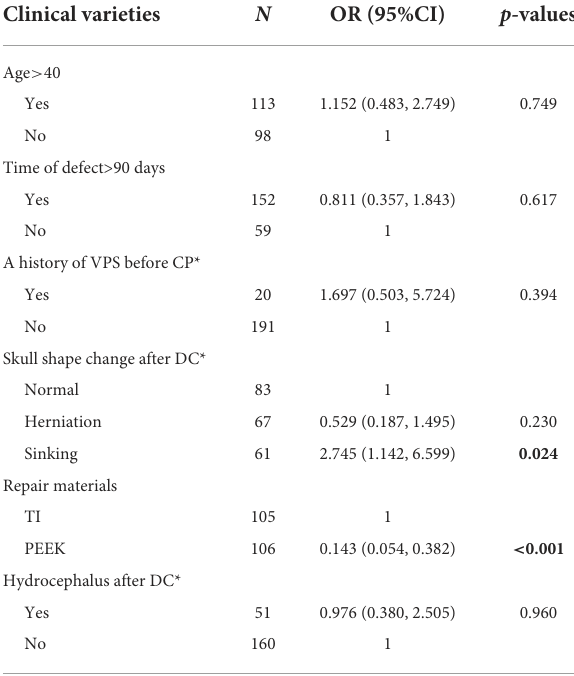
TABLE 8 Multivariate logistics regression analysis on implant failure after